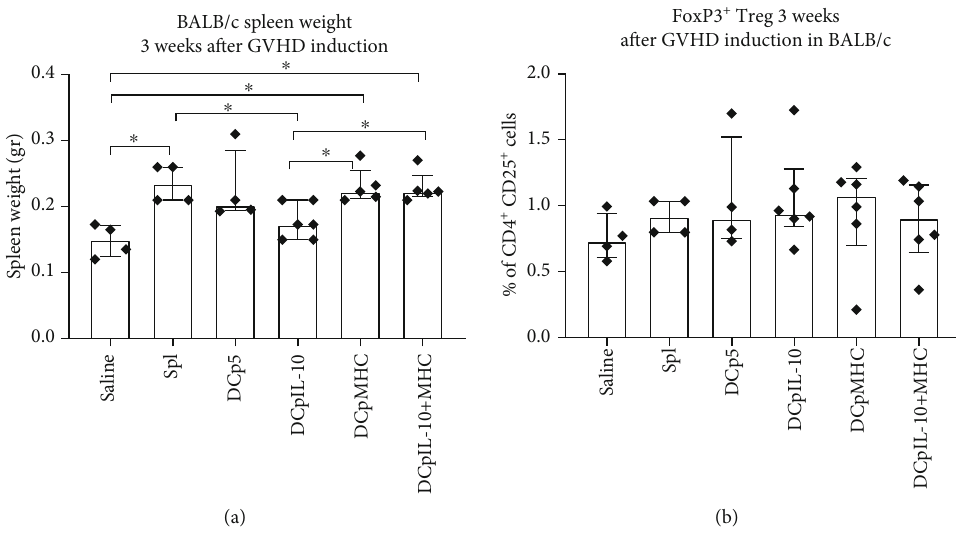
Figure 6: Induction of GVHD in BALB/c mice by splenocytes cocultured with transfected DCs. (a) Spleen weight of BALB/c host mice 3 weeks after GVHD induction. (b) FoxP3 + Treg frequencies in host mouse spleens 3 weeks after GVHD induction. N = 4 per group. Median and interquartile range. Brackets indicate signi fi cant di ff erences (the Kruskal-Wallis test with Dunn ’ s corrected multiple comparisons, ∗ P < 0 : 05 ). Saline: administration of saline; Spl: administration of C57BL/6 mouse splenocytes; DCp5: administration of cocultures of autosplenocytes and DCs electroporated with a control plasmid p5; DCpIL-10: administration of cocultures of autosplenocytes and DCs electroporated with a pIL-10; DCpMHC: administration of cocultures of autosplenocytes and DCs electroporated with a pMHC; DCpIL-10 + MHC: administration of cocultures of autosplenocytes and DCs electroporated with pMHC and pIL-10